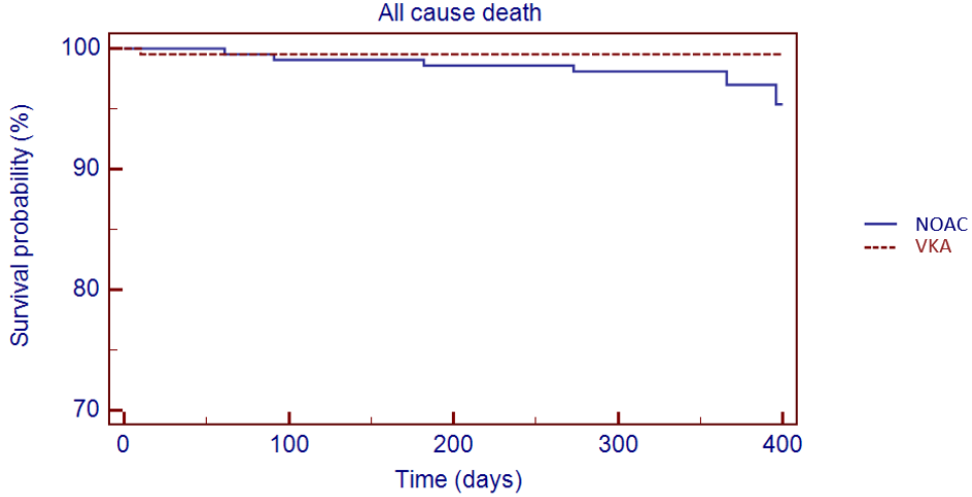
Figure 5. Kaplan–Meier cumulative probability of all-cause death event-free survival in NOAC and VKA treatment group.